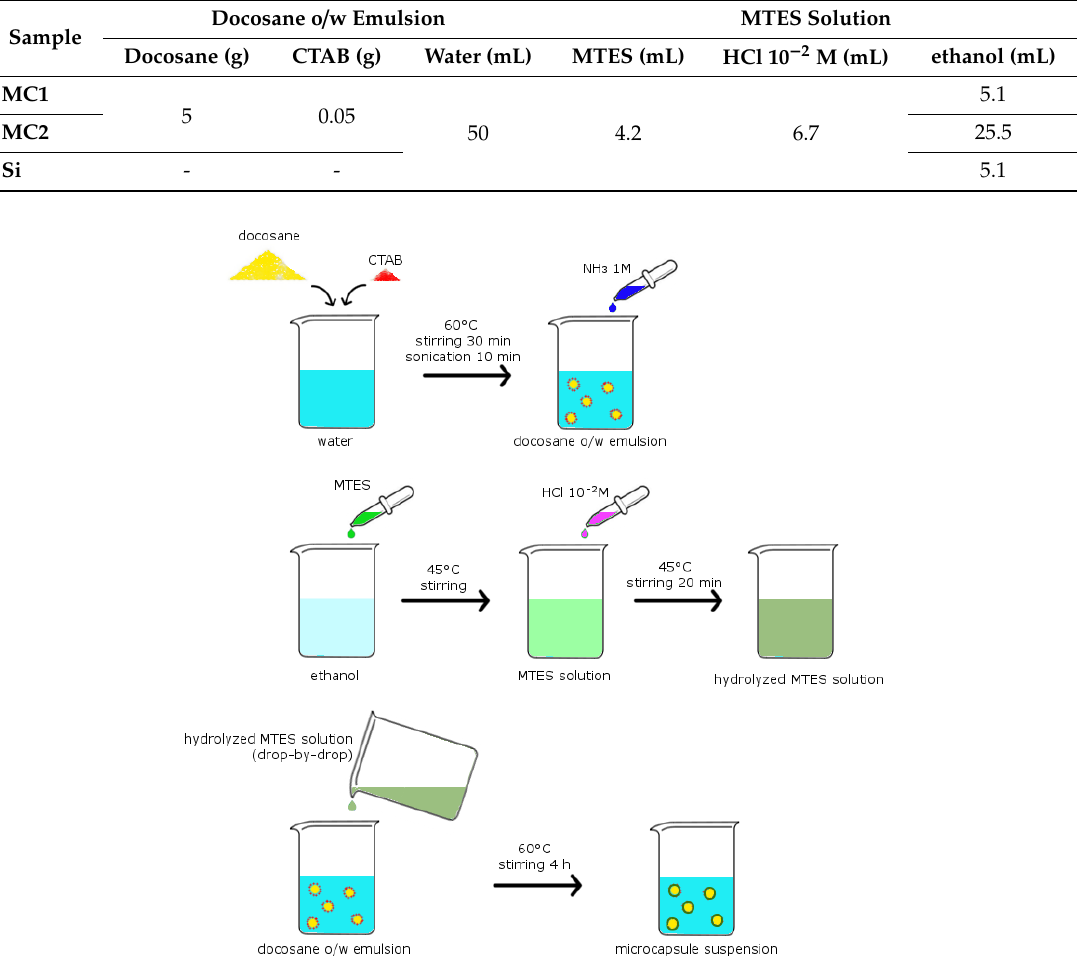
Table 1. Composition of the docosane o / w emulsion and the MTES solution for all the prepared samples.